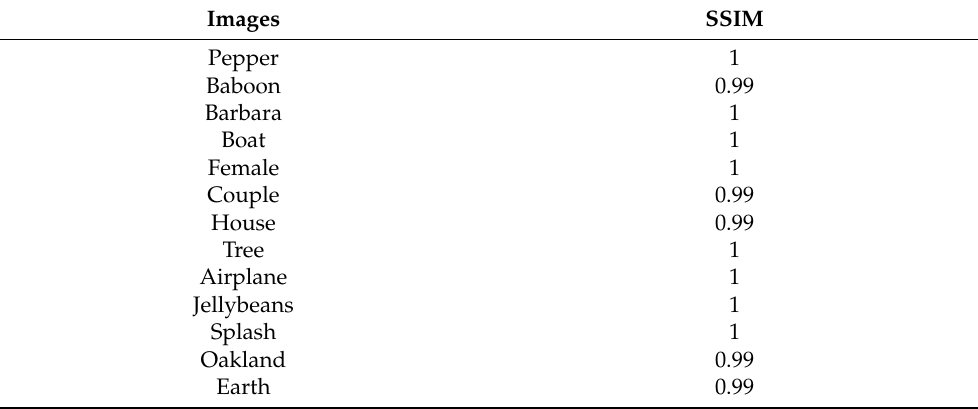
Table 5. SSIM for the standard dataset